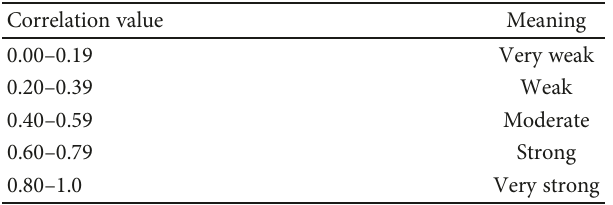
Table 9: The interpretation of The Pearson correlation coe ffi cient [29].